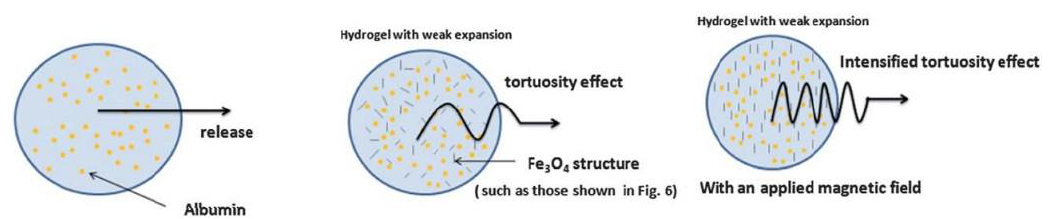
Figure 13. Albumin release from a hydrogel without and with an applied magnetic field: a proposed mechanism. Adapted from Guilherme et al. [97].